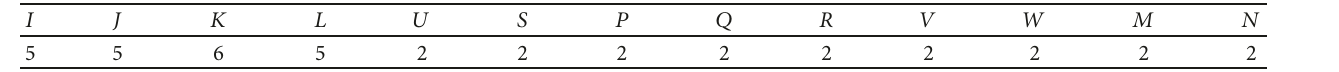
Table 1: Size of the decision variables.